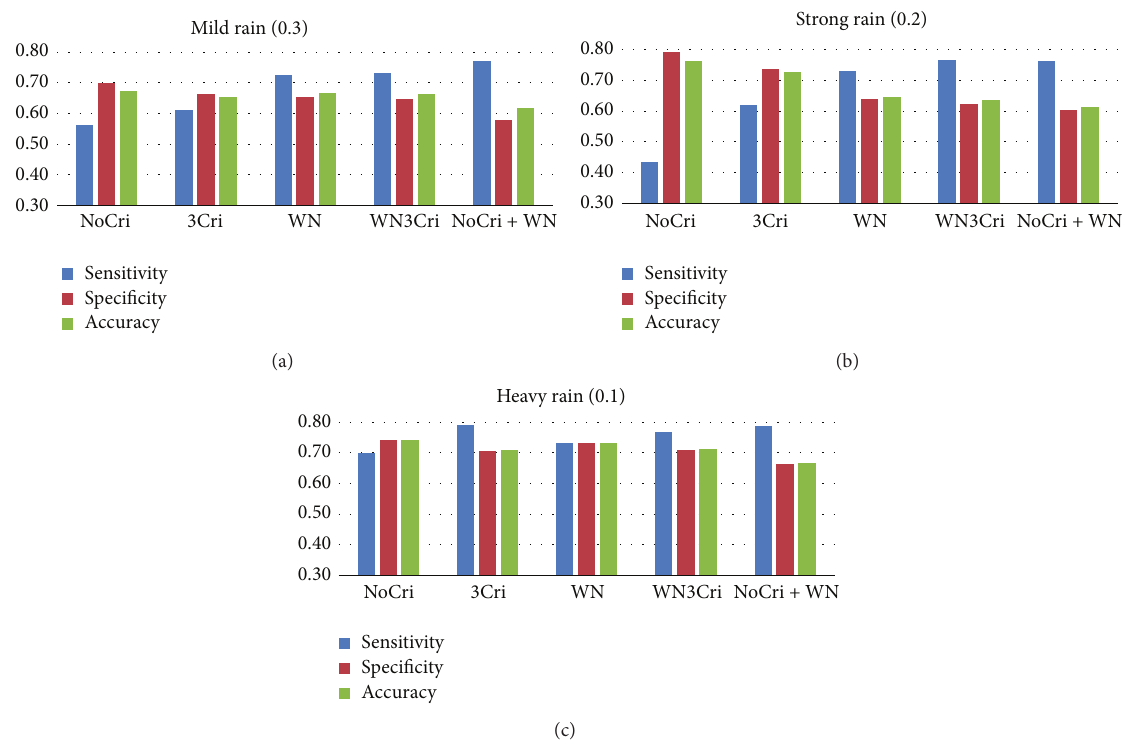
Figure 7: Validation results (sensitivity, specificity, and accuracy) for the probability maps alone and in combinations for the three rain categories. In parentheses are the probability thresholds over which a cyclone is grouped as